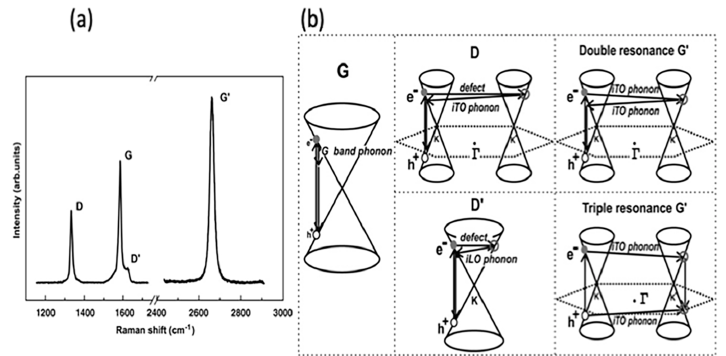
Figure 21. ( a ) characteristic Raman spectra of graphene and ( b ) Raman scattering processes (reprinted with permission from